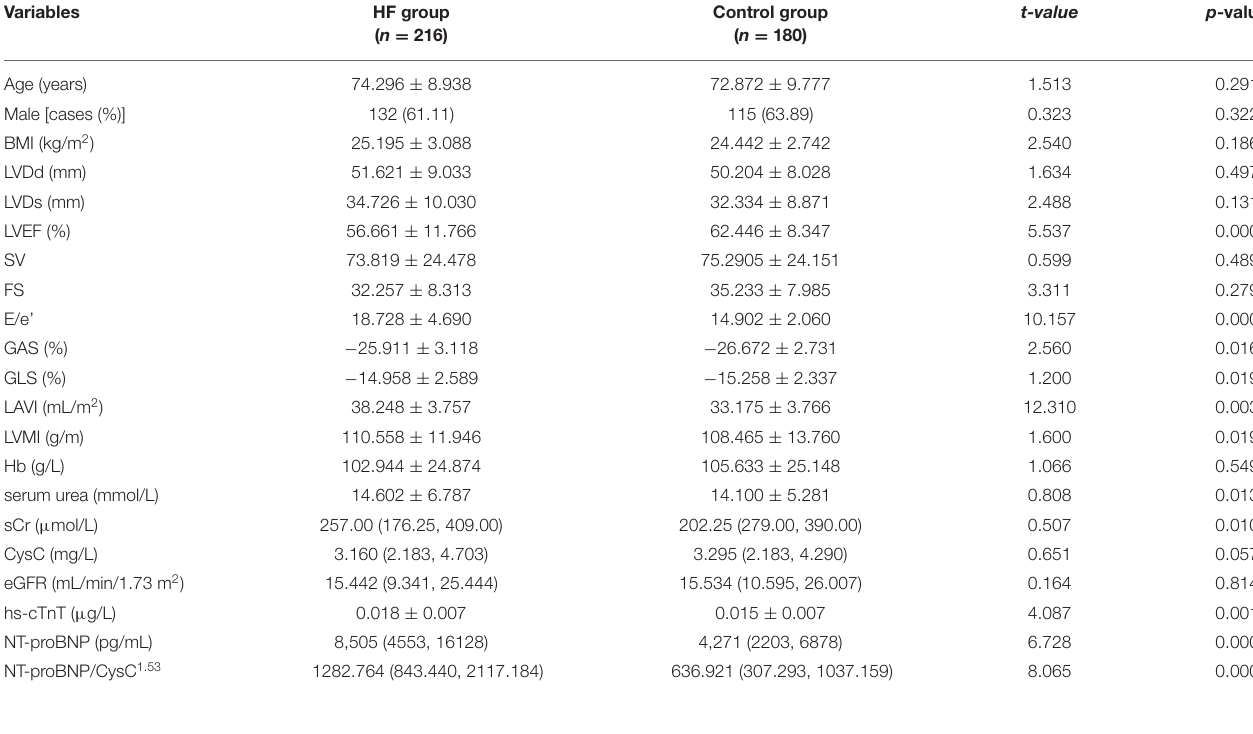
TABLE 1 | Clinical characteristics of CKD patients at baseline.